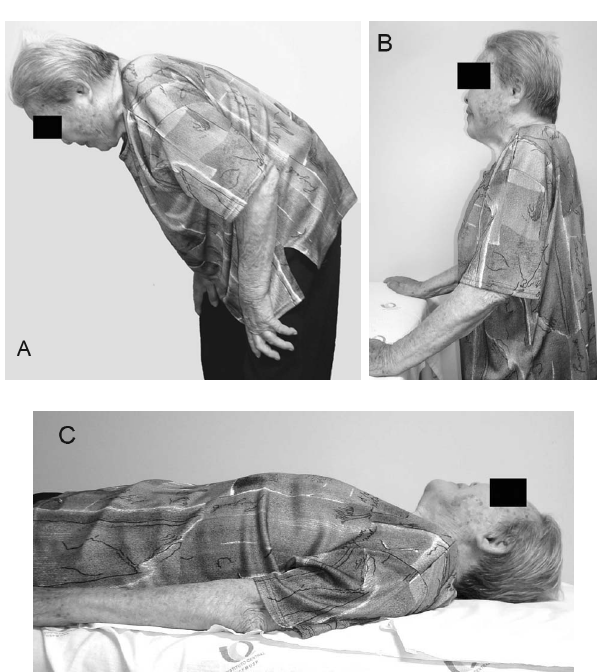
Figure 1 - Patient with camptocormia (A) whose posture markedly improved when when she was allowed to hold onto a table, (B) or when she lay in a supine position